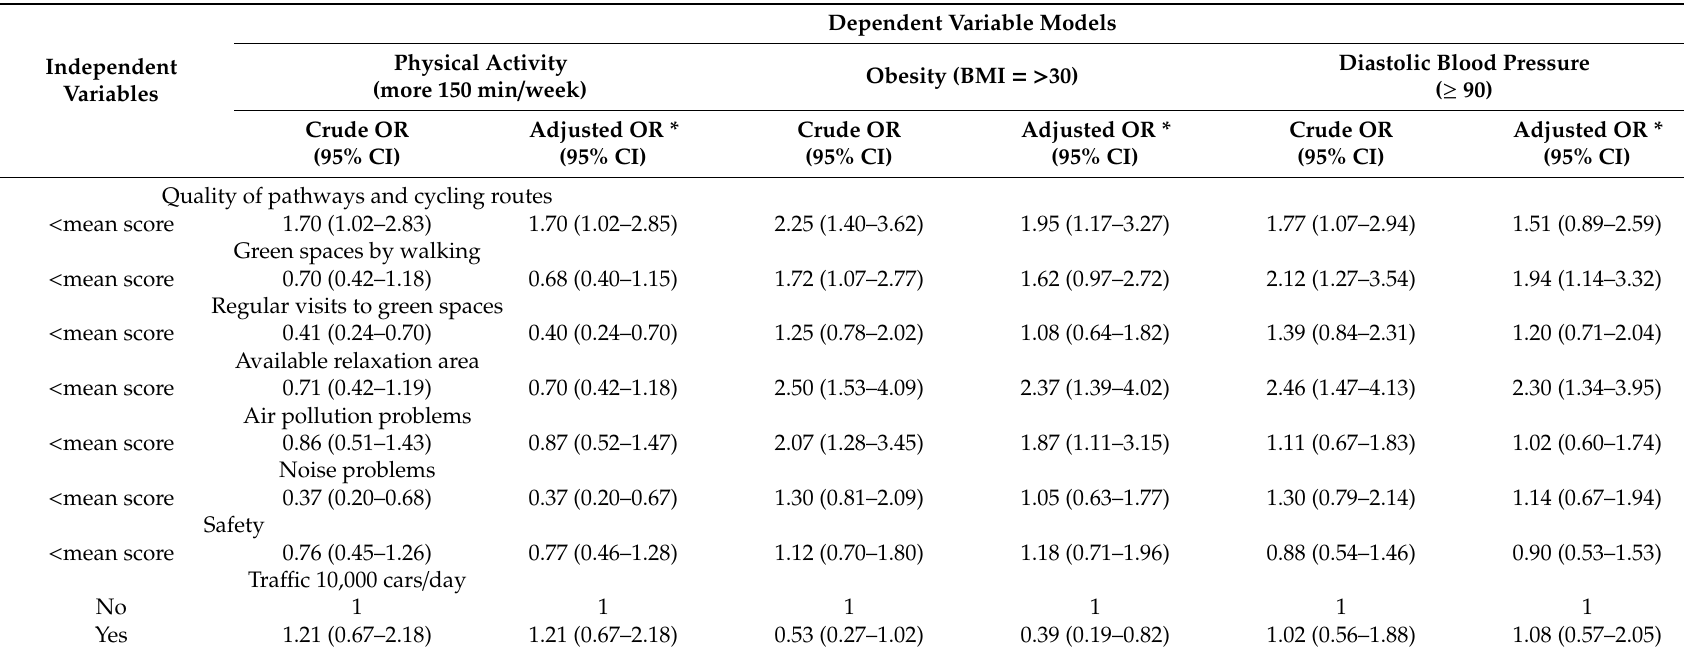
Table 4. Multivariate logistic regression models of neighborhood quality items on physical activity, obesity, and diastolic blood pressure.